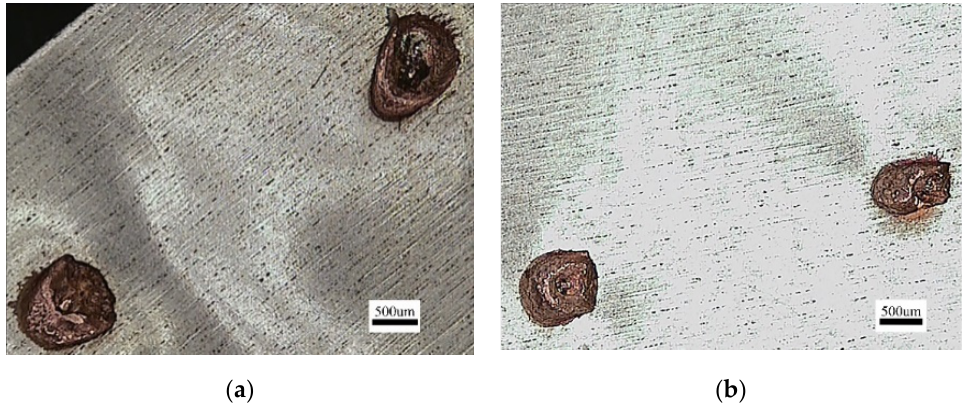
Figure 9. Method II validation figure. ( a ) No. 1 validation figure; ( b ) No. 2 validation figure. Table 9. Method II verification of relative error.